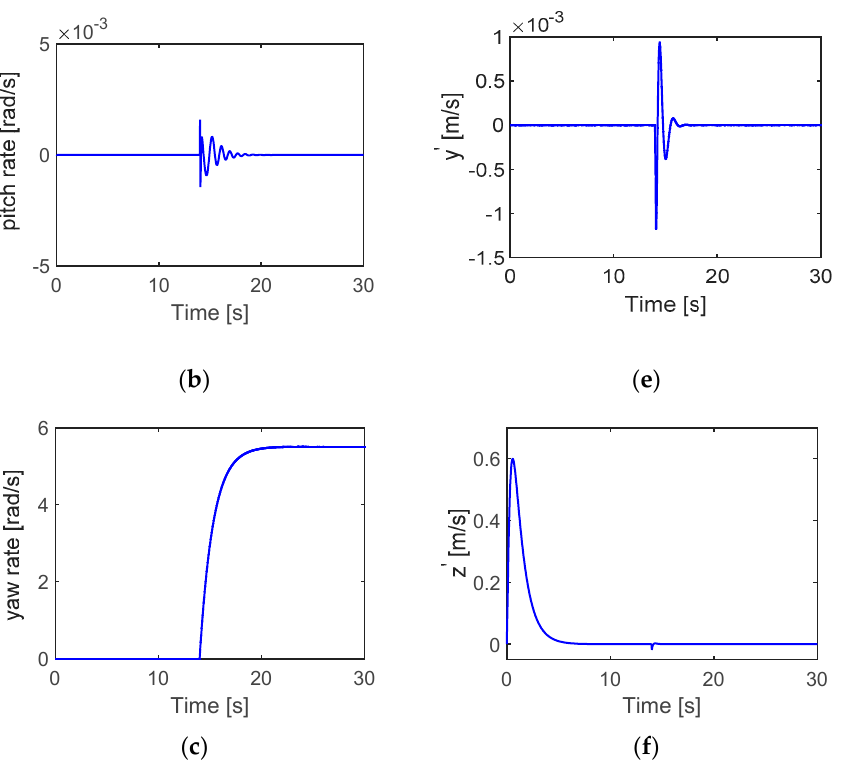
Figure 9. Angular rates and linear velocities for scenario 1: ( a ) Roll rate, ( b ) Pitch rate, ( c ) Yaw rate, ( d ) velocity of x-direction, ( e ) velocity of y-direction, and ( f ) velocity of z-direction.